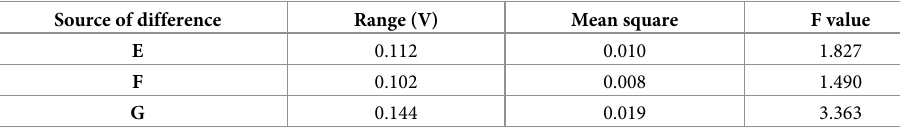
Table 4. Data analysis results for optimal parameters for sieve plate structure and